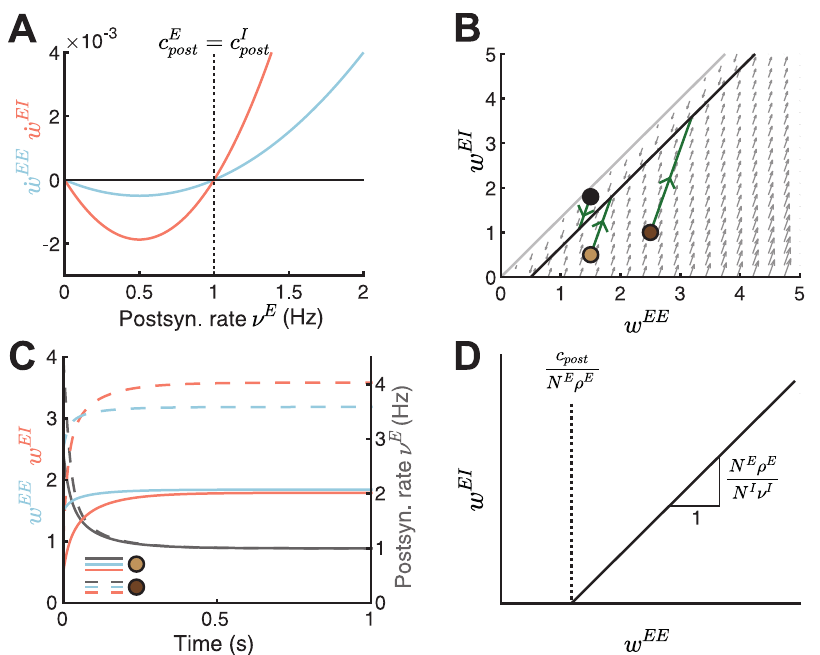
Fig 2. A novel nonlinear inhibitory plasticity rule can counteract runaway dynamics of excitatory-to-excitatory weights. A . Plasticity curves of E-to-E ( _ w EE , blue) and I-to-E ( _ w EI , red) weights as a function of the postsynaptic rate ν E . The excitatory and inhibitory LTD/LTP thresholds are identical ( c E ¼ c I ). B . Phase portrait of the dynamics of E- post post to-E ( w EE ) and I-to-E ( w EI ) weights. Gray arrows indicate the direction of weight evolution over time, points represent three different initial conditions of the weights, ½ w EE ; w EI � ¼ f½ 1 : 5 ; 1 : 8 � ; ½ 1 : 5 ; 0 : 5 � ; ½ 2 : 5 ; 1 �g , and green lines represent 0 0 the weight evolution for each initial condition. The two colored points represent initial weights in C. Black line indicates the line attractor and the gray line separates the space at which the postsynaptic firing rate is zero (no dynamics) or larger than zero (Methods, Eq 18). C . E-to-E ( w EE , blue) and I-to-E ( w EI , red) weight dynamics and postsynaptic rate dynamics ( ν E , gray) as a function of time for two initial conditions in B, ½ w EE ; w EI � ¼ ½ 1 : 5 ; 0 : 5 � (solid 0 0 lines) and ½ w EE ; w EI � ¼ ½ 2 : 5 ; 1 � (dashed lines). D . The slope and intersection of the line attractor with the abscissa (black 0 0 line) depend on the number and firing rates of excitatory and inhibitory neurons and the LTD/LTP threshold.